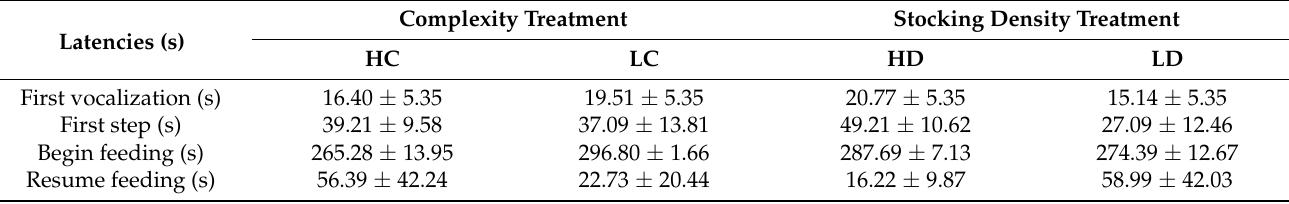
Table 4. Least squares mean estimates (s ± SEM) for latency to first vocalization ( n = 60), first step ( n = 45), and begin feeding ( n = 60), as well as raw means (s ± SEM) for latency to resume feeding ( n = 7) for broiler chickens kept in high-complexity (HC), low-complexity (LC), high-density (HD), and low-density (LD) treatments in Experiment 1 at 4 weeks of age (days 30, 32, and